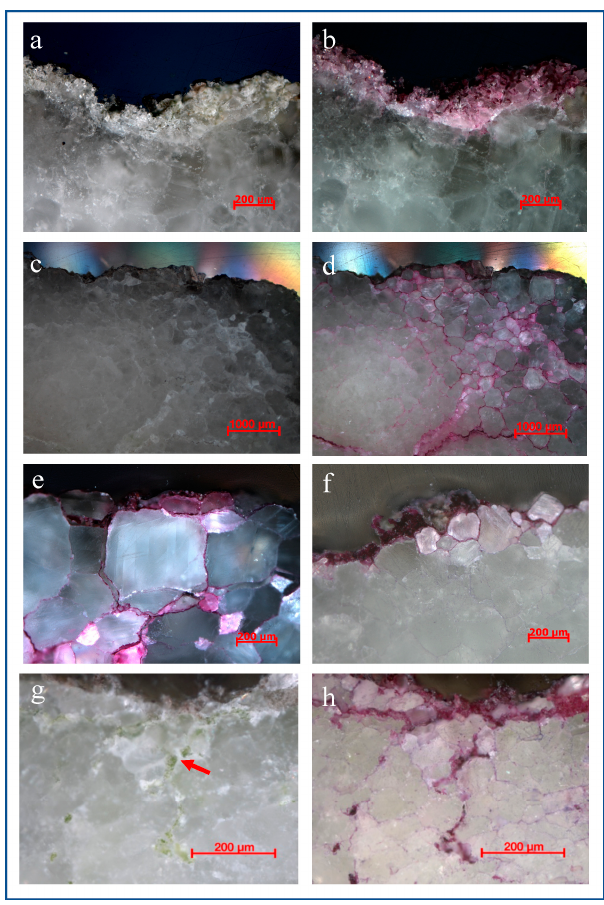
Figure 4. Biological colonization of SMFC marble observed by marble polished cross sections. SMF1 (NW) cross section before ( a ) and after ( b ) PAS staining; SMF6 (SE) cross section before ( c ) and after ( d ) PAS staining; ( e ) a detail of d; ( f ) PAS-stained cross section of SMF2 (NW); SMF9 (SE) cross section before ( g ) and after ( h ) PAS staining, endolithic algae (arrow) are visible in ( g